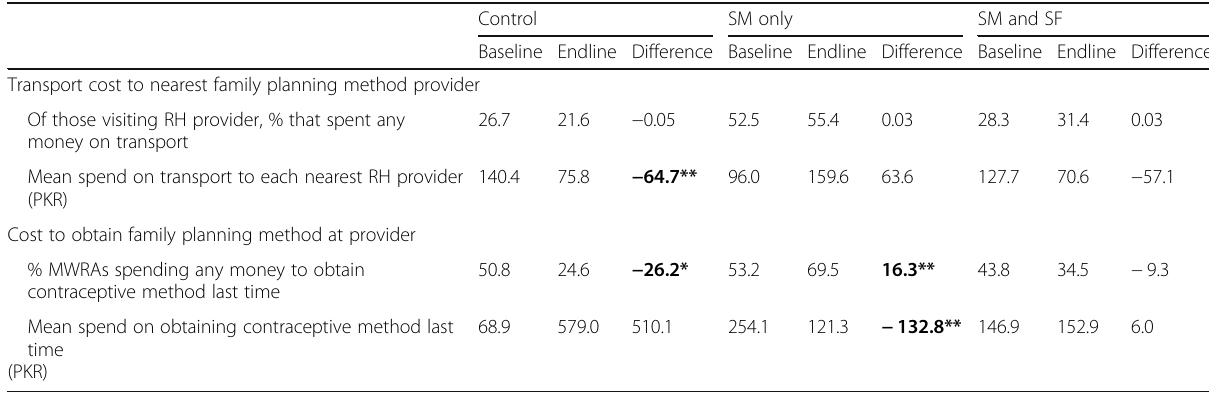
Table 2 User costs for transport and FP methods